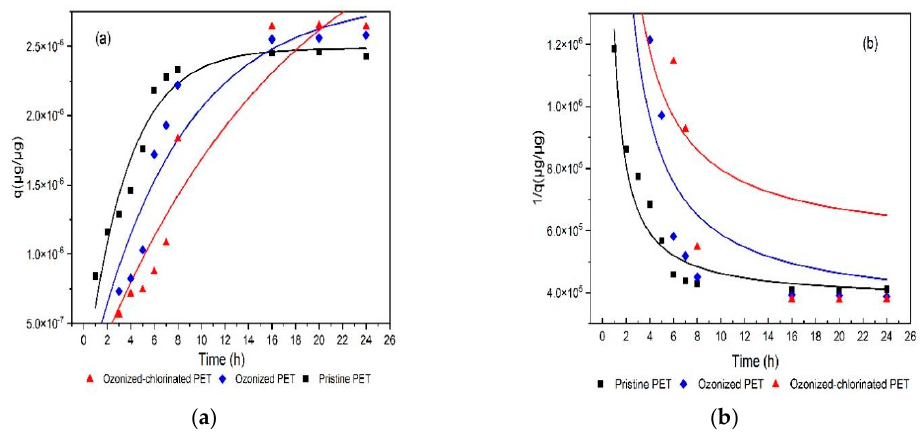
Figure 7. Kinetics model of TBM adsorption by pristine PET, ozonized PET, and ozonized − chlorinated PET. ( a ) Pseudo − first − order model, ( b ) pseudo − second − order model.